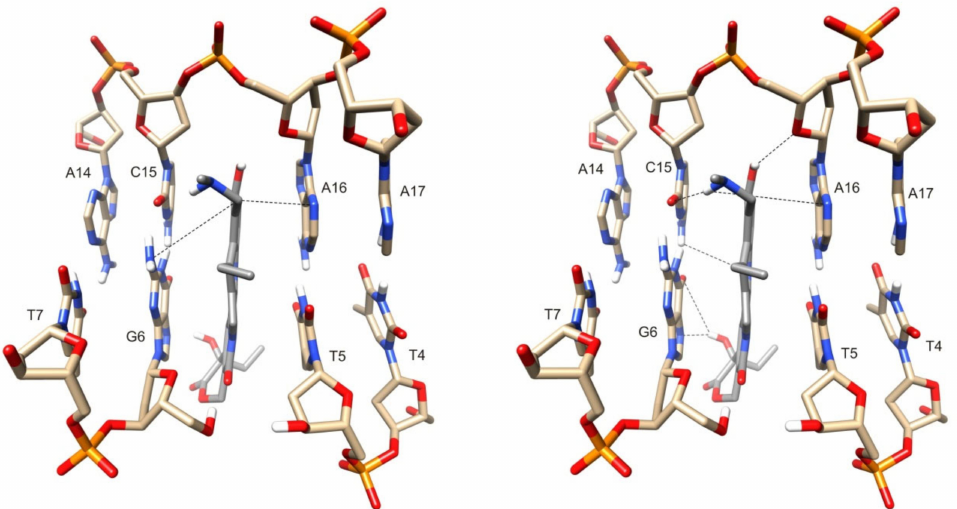
Figure 3. Molecular view of the second probable geometry of a complex 1 + 2. Structure 3 from MD trajectories (Figure S12). The molecule of 2 is turned over by 180 ◦ with respect to structure 1. The N–CH 3 group is pointing into a minor groove. The left panel shows internuclear contact for possible hybrid formation. The right panel shows possible hydrogen bonds stabilizing the structure (see Figure S13 and Table S4 for internuclear distances and